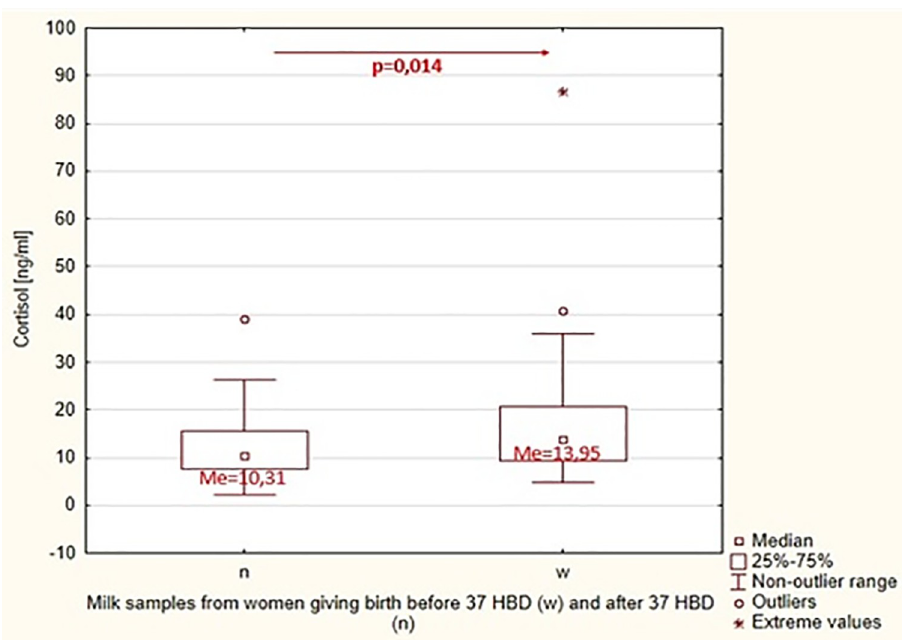
Fig 1. Statistical significance of differences in cortisol concentration in breast milk between the group of women giving birth before and the group of women giving birth after 37 weeks of pregnancy. n-milk samples from women giving birth after 37 HBD, w-milk samples from women giving birth before 37 HBD.